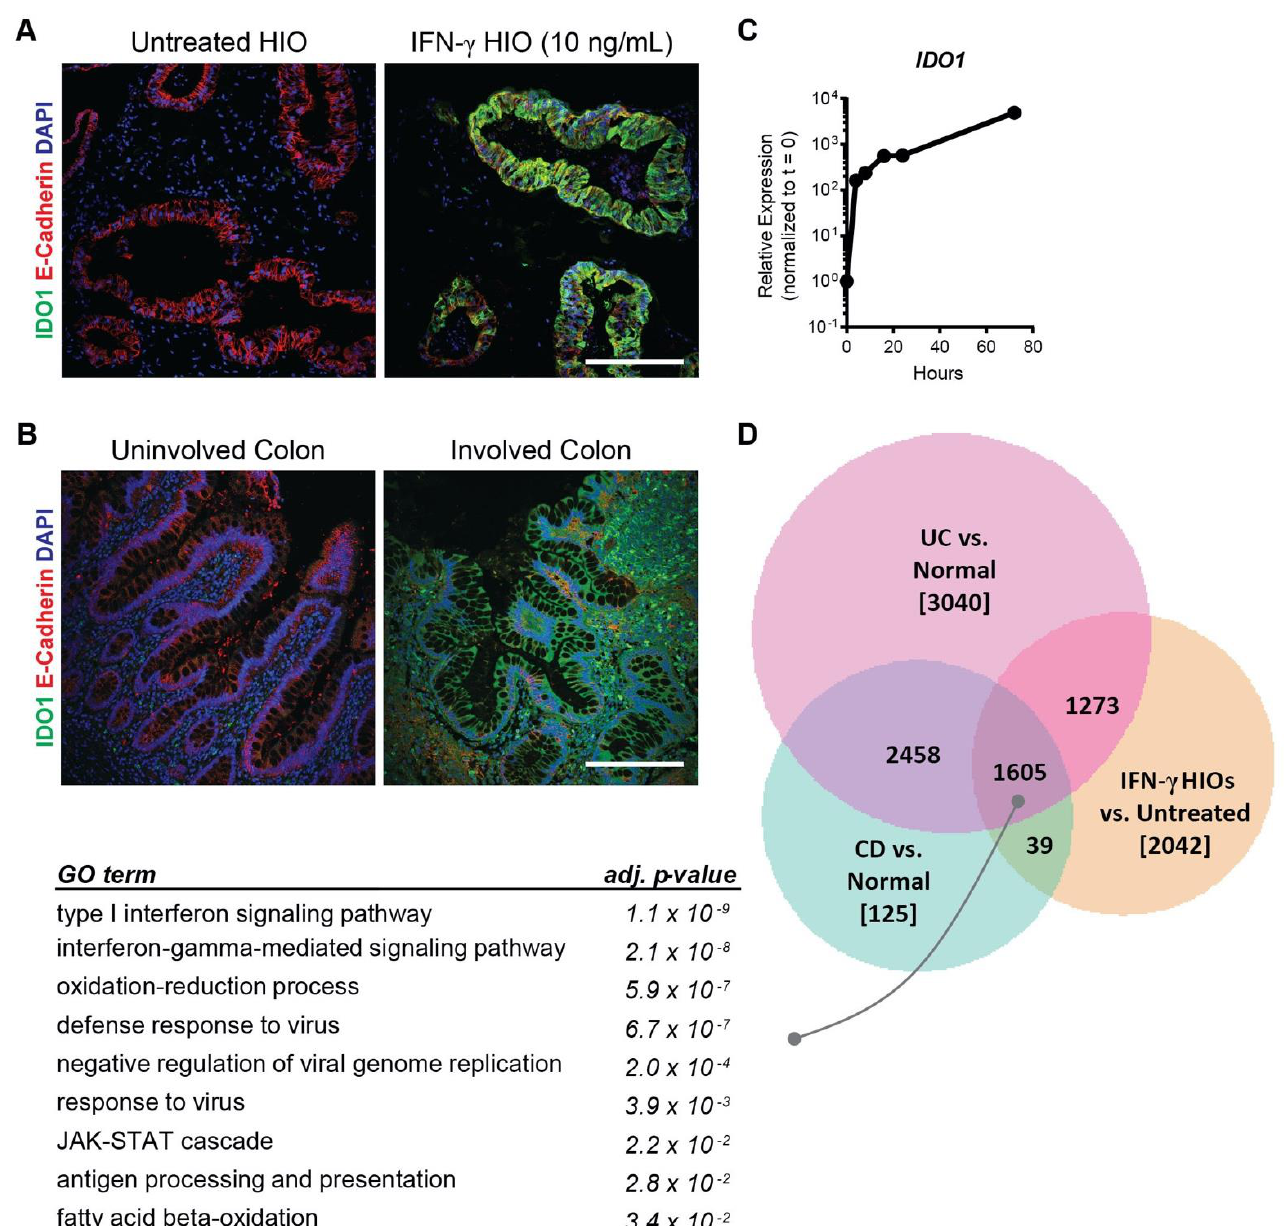
Figure 6. iPSC-derived organoids capture IBD-relevant changes in intestinal tissue. ( A ) IFN- γ -treated HIOs display significant upregulation of IDO1. Scale Bar = 200 µ m ( B ) Colonic biopsies from Crohn’s disease patients show similar upregulation of IDO1 in involved segments of intestinal tissue. Scale Bar = 200 µ m ( C ) IDO1 is highly upregulated within 4 h of IFN- γ exposure and stays elevated throughout treatment. ( D ) Overlap of differentially expressed genes in IFN- γ -treated HIOs and CD and UC biopsies versus untreated HIOs and healthy control biopsies, respectively, shows enrichment of pathways associated with interferon signaling, immune response, and JAK-STAT cascade.